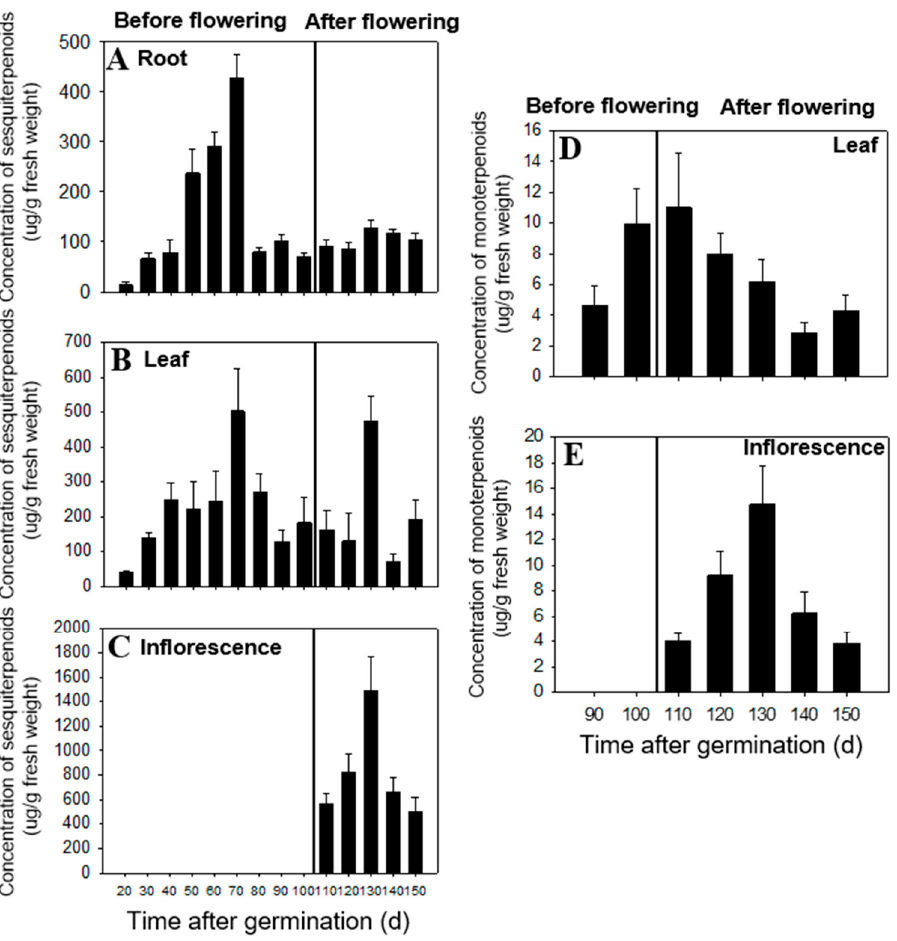
Figure 1. Concentration of total sesquiterpenoid ( A – C ) and monoterpenoid ( D , E ) compounds in roots, leaves, and flowers of C. iria at different developmental stages. Standard error is denoted for each bar.